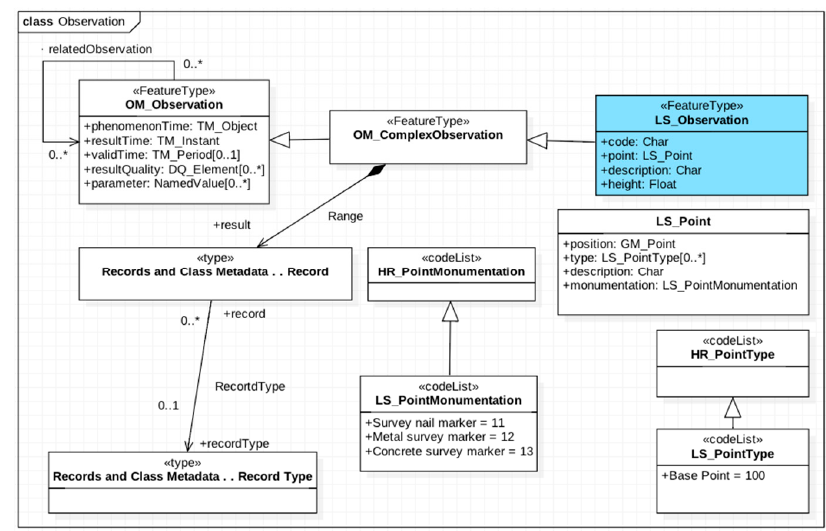
Figure 5. ‘LS_ Observation’ core class diagram.